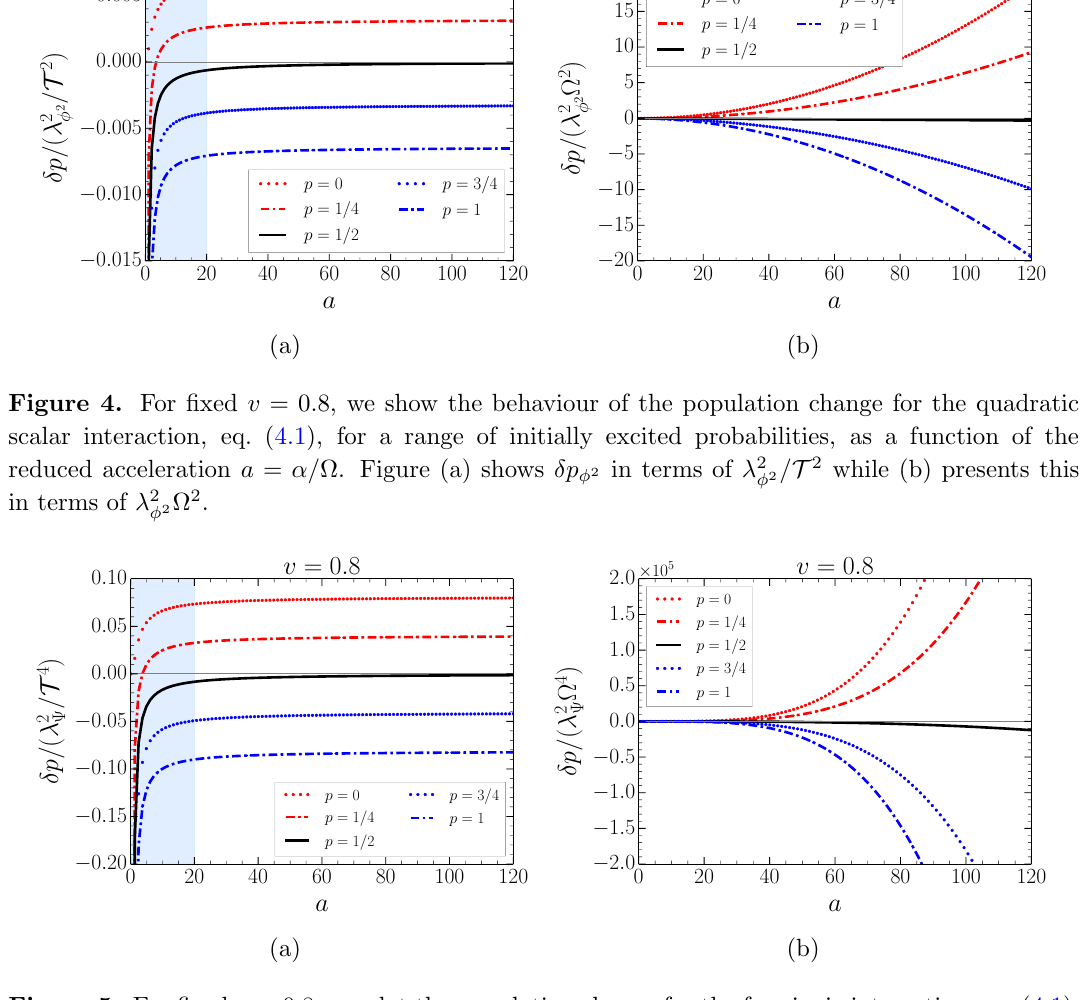
4 while = (cid:9) T